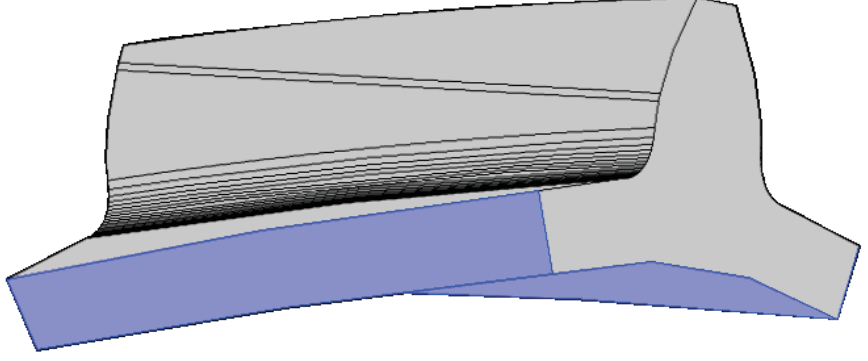
Figure 9: Outline of helical tooth, the specific contact area selected is shown for constant contact width of 1mm. The clamped boundaries are indicated by a different colour for the side and bottom.